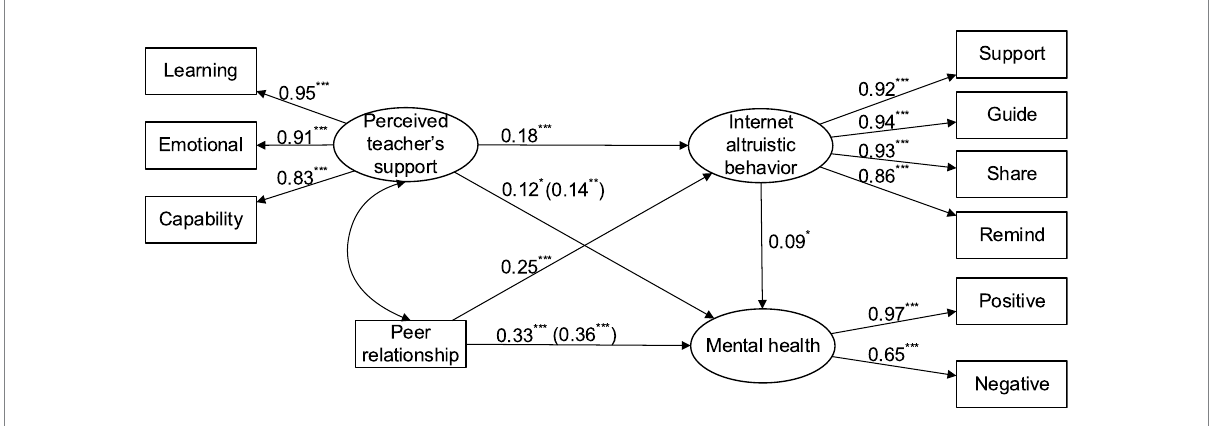
FIGURE 2 Relationships of perceived teacher’s support, peer relationship, Internet altruistic behavior, and mental health. * p < 0.05, ** p < 0.01, *** p < 0.001.